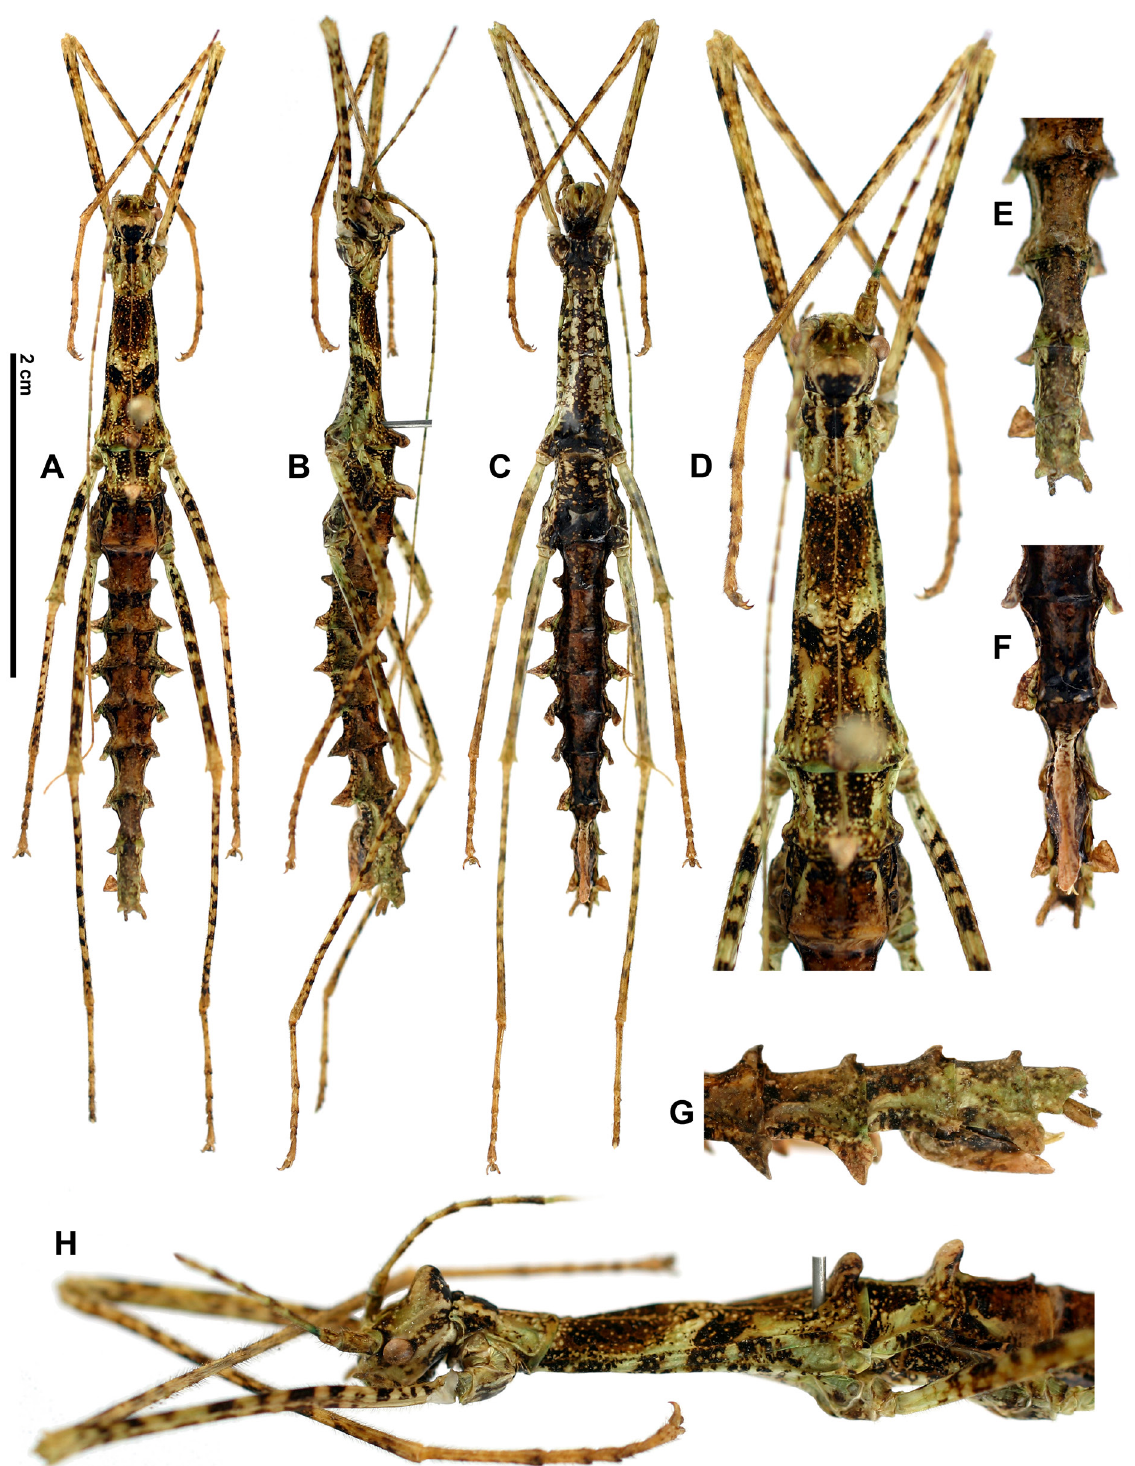
Fig. 7. Otraleus bellemansae sp. nov., ♀, paratype. A . Habitus, dorsal view. B . Habitus, lateral view. C . Habitus, ventral view. D . Anterior part of body, dorsal view. E . Apex of abdomen, dorsal view. F . Apex of abdomen, ventral view. G . Apex of abdomen, lateral view. H . Anterior part of body, lateral view. D–H: not to